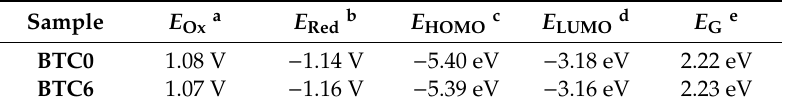
Table 2. The electrochemical HOMO-LUMO band gaps for BTC0 and BTC6.